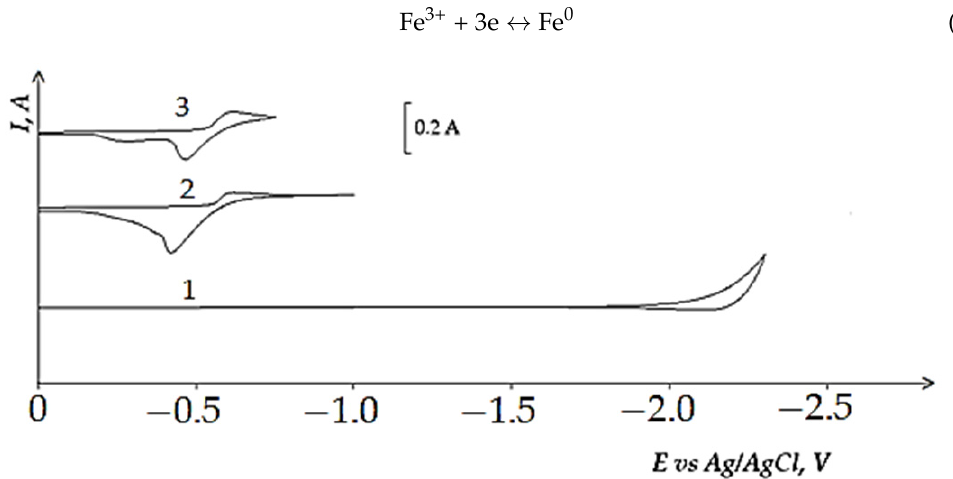
Figure 3. Cyclic voltammograms of the equimolar KCl-NaCl melt containing FeCl3, recorded on the tungsten electrode at 973 K. Concentration of FeCl3: curve 1–0 mol/cm 3 , curves 2 and 3–1.0 × 10 − 4 mol/cm 3 . Polarization rate is 0.2 V/s. A square of the cathode is 0.64 cm 2 .